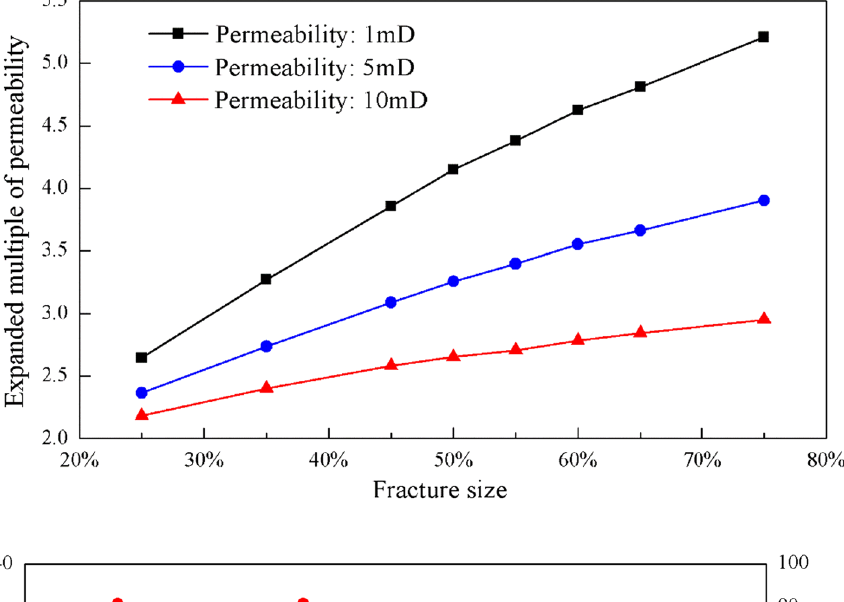
Fig. 7 Interlayer apparent mobility contrast at different permeability